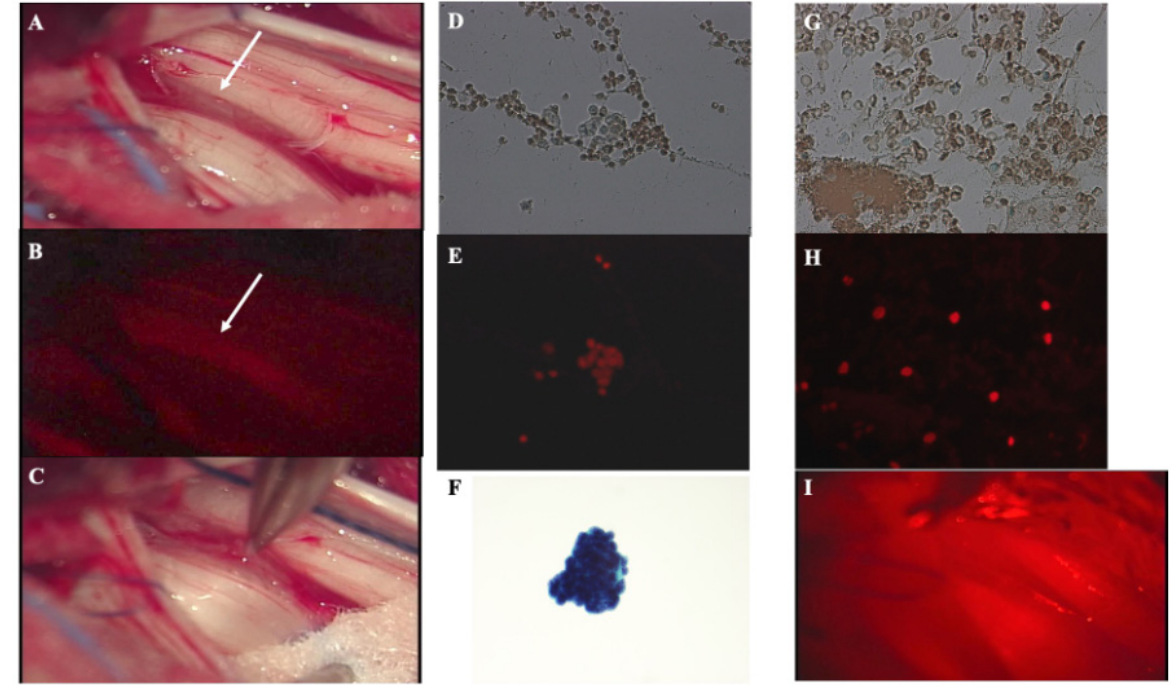
Figure 2. Intraoperative findings of the lumbar surgery and practice of PD and PDT for the tumor located in the conus medullaris. ( A ): Intraoperative finding of an intradural lumbar lesion demon- strating a gelatinous pink tumor located in the conus medullaris between the cauda equina (white arrow). ( B ): Intraoperative PD using a surgical microscope demonstrated weak fluorescencefrom the tumor (white arrow). ( C ): Piece by piece resection of the tumor. ( D , G ): Intraoperative fluores- cence cytology of sediment from the CSF ( D ) and resected tumor tissue ( G ) under white light demonstrated a cluster of tumor cells. ( E , H ): Intraoperative fluorescence cytology of the sediment from the CSF ( E ) and resected tumor tissue ( H ) demonstrated strong fluorescence of talaporfin so- dium in the cytoplasm of the cluster of tumor cells with a high N/C ratio. ( F ): Giemsa stain (×400) of the sediment from the CSF demonstrated a cluster of tumor cells. ( I ): We performed a single shot of irradiation of PDT to the conus medullaris. The magnification of histological images: ( D , E , G ): ×200, ( F , H ): ×400. 4. Postoperative Course The histopathological diagnosis of the lesion in the conus medullaris was malignant small round cell tumor with a high N/C ratio. (Figure 3A,B) After surgery, CSF leakage from the surgical wound continued, and we performed reclosure of the dura mater using perifascial areolar tissue and a subcutaneous fat graft 4 days after the lumbar surgery. The patient’s severe preoperative lumbago gradually improved and he started physical ther- apy. The patient also started chemotherapy of weekly intrathecal injections using metho- trexate (MTX) (6 mg/m 2 ) and cytosine arabinoside (Ara C) (20 mg/m 2 ), and concurrent oral administration of temozolomide (TMZ) (150 mg/m 2 ) per day, 5 days/28 days. Three weeks after the surgery, his sciatica gradually improved and he became able to walk by himself using a T cane. Lumbar MRI displayed a faint enhanced lesion in the conus medullaris, and disappearance of enhancement in the caudal part of the dura mater. Cytology of the CSF also demonstrated improvement from Class III b to Class II. (Figure 3C) As the patient and his family strongly wished for him to be the discharged to go home, intrathecal chem- otherapy was terminated after 3 cycles, but temozolomide administration was continued. However, only 2 weeks after discharge, the patient presented with severe neck pain and arm numbness. Brain MRI displayed no apparent recurrence of the primary cerebellar